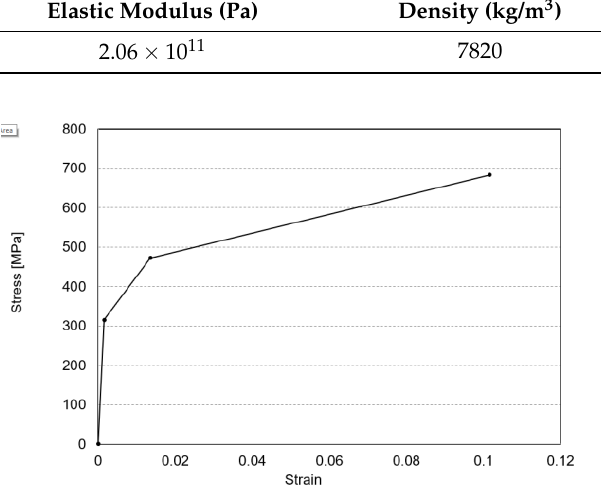
( b ) Figure 12. Behavior after UHPC linear elastic region for ( a ) compression behavior and ( b ) tensile behavior). 3.2.3. Contact Properties The anchor block is a sandwich-type joint of steel plates on the front and rear surfaces of the UHPC block and is mainly compressed by the action of the load and the reaction force. Therefore, in this analysis, it was assumed that the UHPC and the front and rear